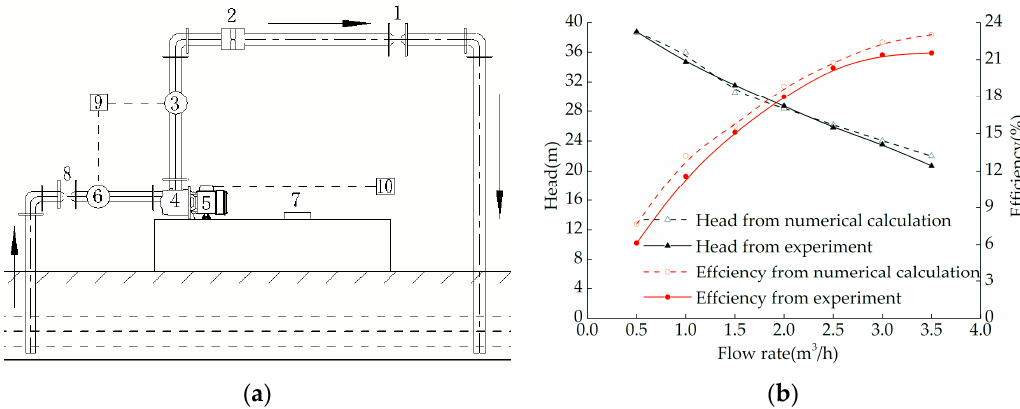
Figure 3. Experimental system and result. ( a ) Experimental system; ( b ) A comparison of hydraulic performance between the experiment and the numerical simulation. 1: Valve at pump outlet; 2: Flowmeter; 3: Pressure sensor at pump outlet; 4: The model pump; 5: Electric motor; 6: Pressure sensor at pump inlet; 7: Tachometer; 8: Valve at pump inlet; 9: Computer; 10: Measuring instrument of electric power.